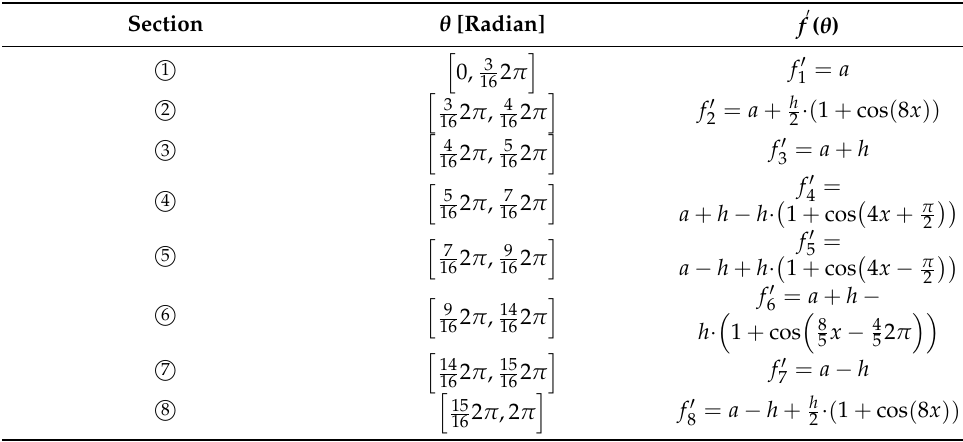
Table 1. Boundaries of sectional angular and each function.